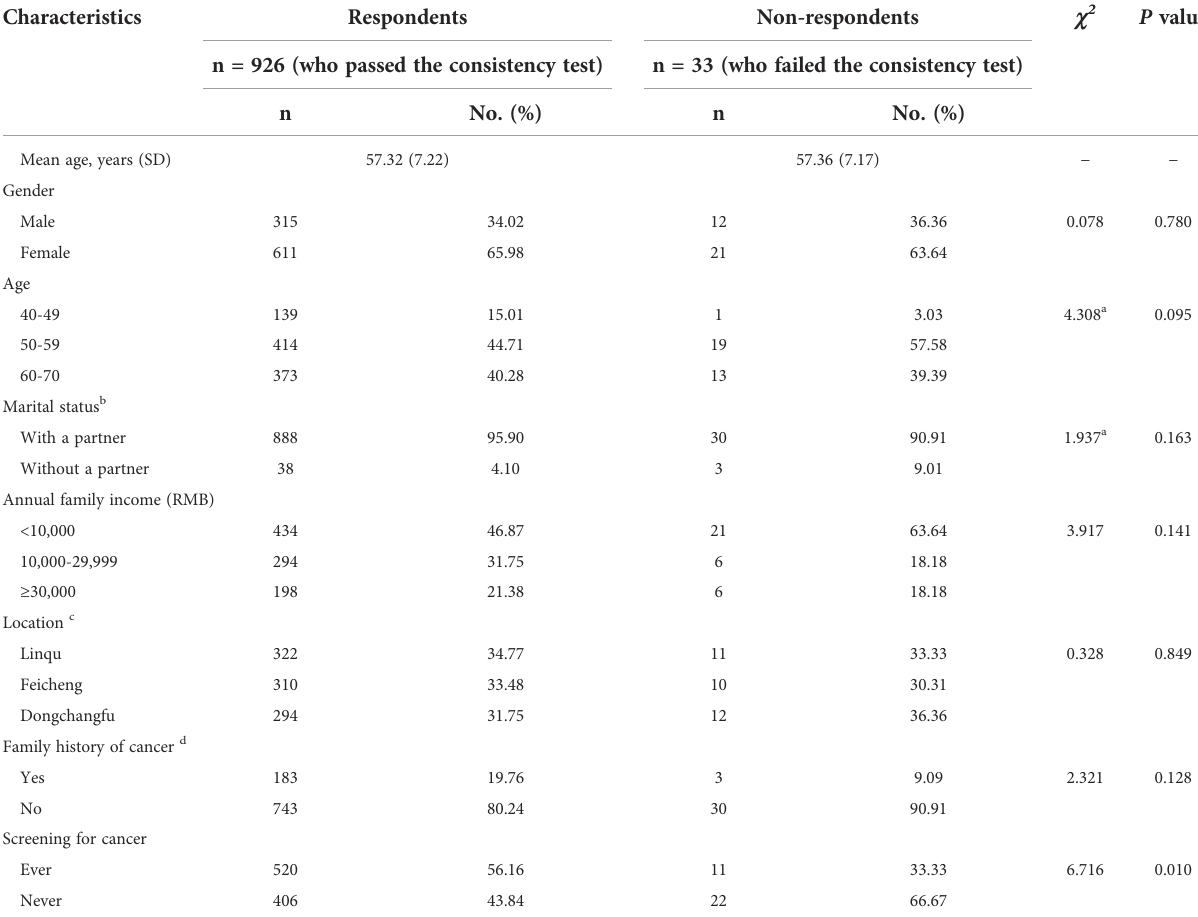
TABLE 2 Characteristics of the respondents.